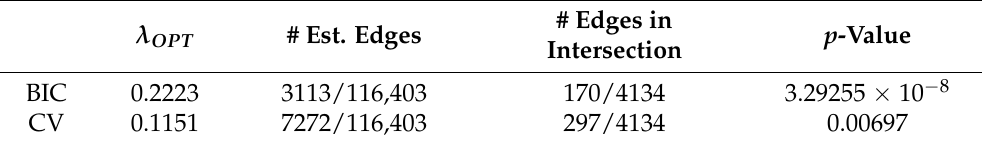
Figure 8. Intersection of the networks estimated with jewel from glioblastoma datasets and the one obtained from the STRING database. Regularization parameter, used in the estimation, was obtained with BIC (on the left) and with CV (on the right). Table 3. Results of BIC and CV procedures obtained for K = 3 glioblastoma datasets with p = 483 over the uniform in log-scale grid of 50 parameters of λ from 0.01 to 1. The p -values is the results of the hyper-geometric test to assess the significance of the edge